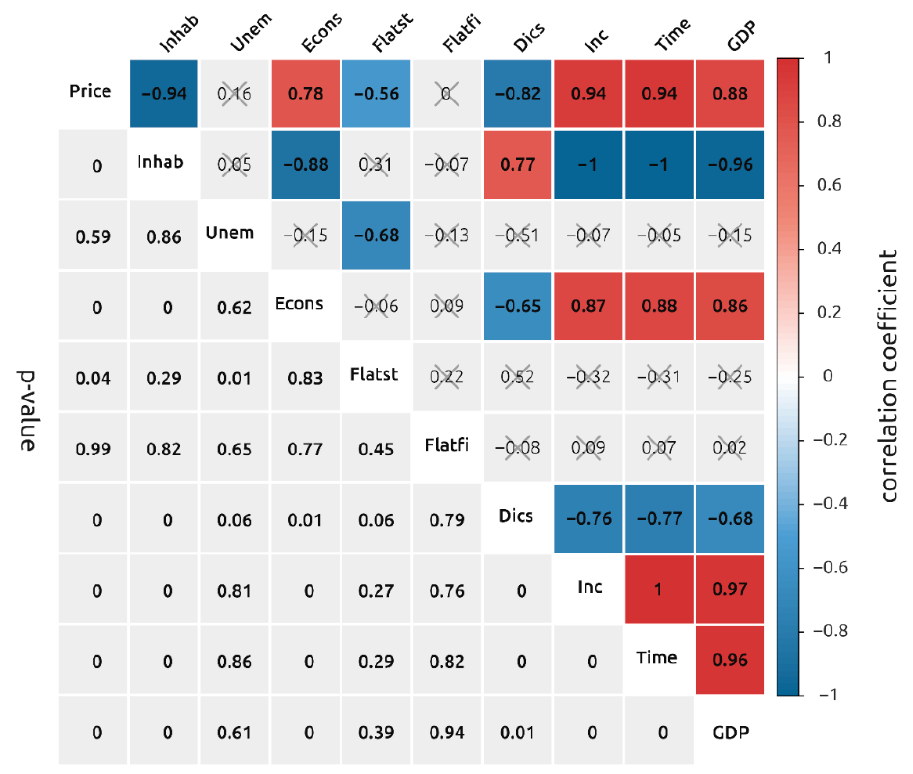
Figure 5. Correlation matrix for the city of Ostrava. Table 4. Regression analysis for Ostrava.